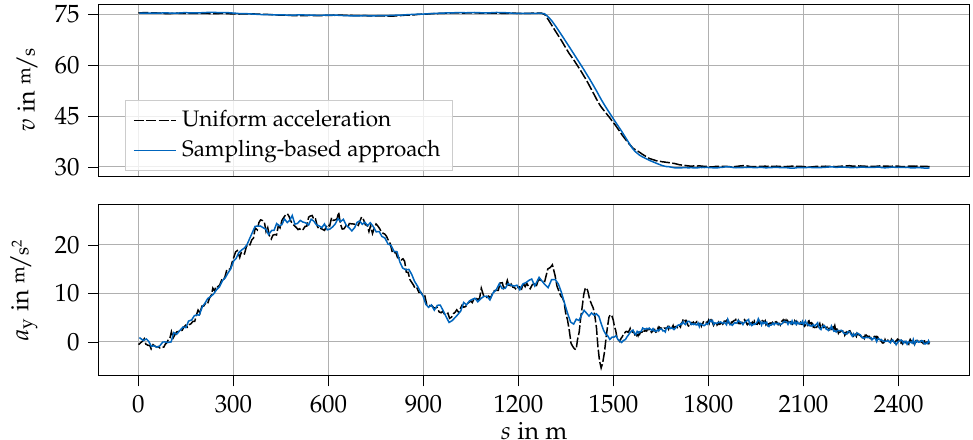
Figure 8. Sampling-based approach and uniform acceleration approach comparison for a braking maneuver from 75 m/s to 30 m/s on the mainstretch of the